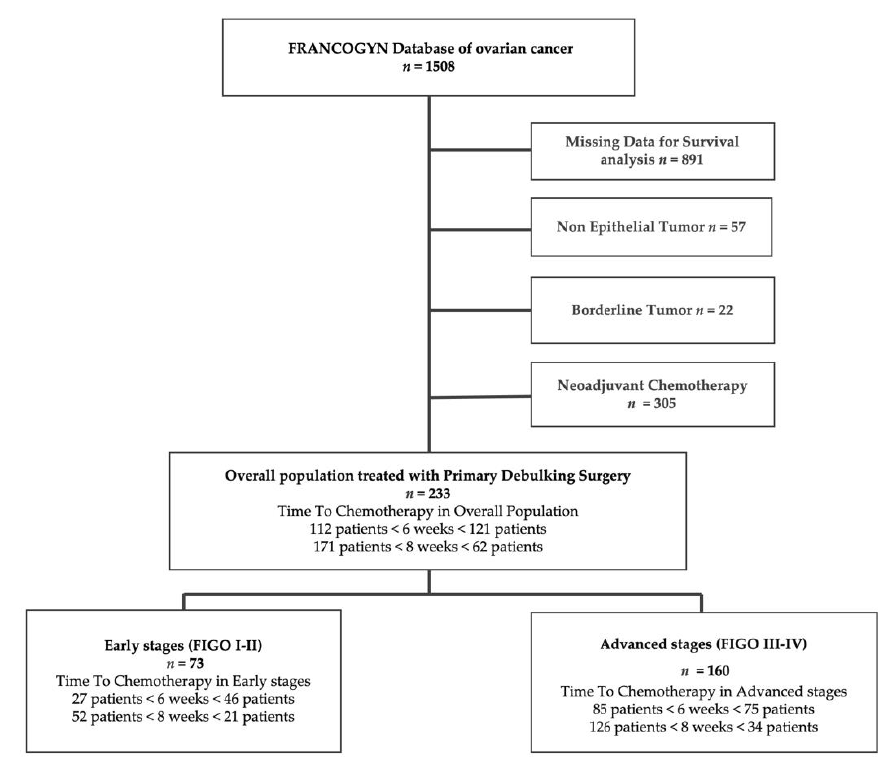
Figure 1. Study flowchart. FIGO: International Federation of Gynecology and Obstetrics classification.